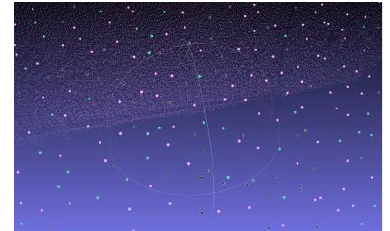
Figure 14 . Point cloud with triangular grid vertices Colour distribution: The first step is to reconstruct the face elements from the alpha-shape 3D reconstruction into a Mesh. The Mesh contains the vertices and triangulated mesh faces of the 3D reconstruction, and in the colour distribution algorithm each vertex in the Mesh is searched to find its nearest neighbour on the rendered point cloud (the nearest neighbour in the algorithm is set to 3), i.e. the search index is the kd-tree established in the previous step for the rendered point cloud. The RGB colour of each point on the mesh is then assigned to the mean of the RGB values of the neighbouring points, and this step is repeated for the entire mesh to render the 3D reconstructed tunnel model.